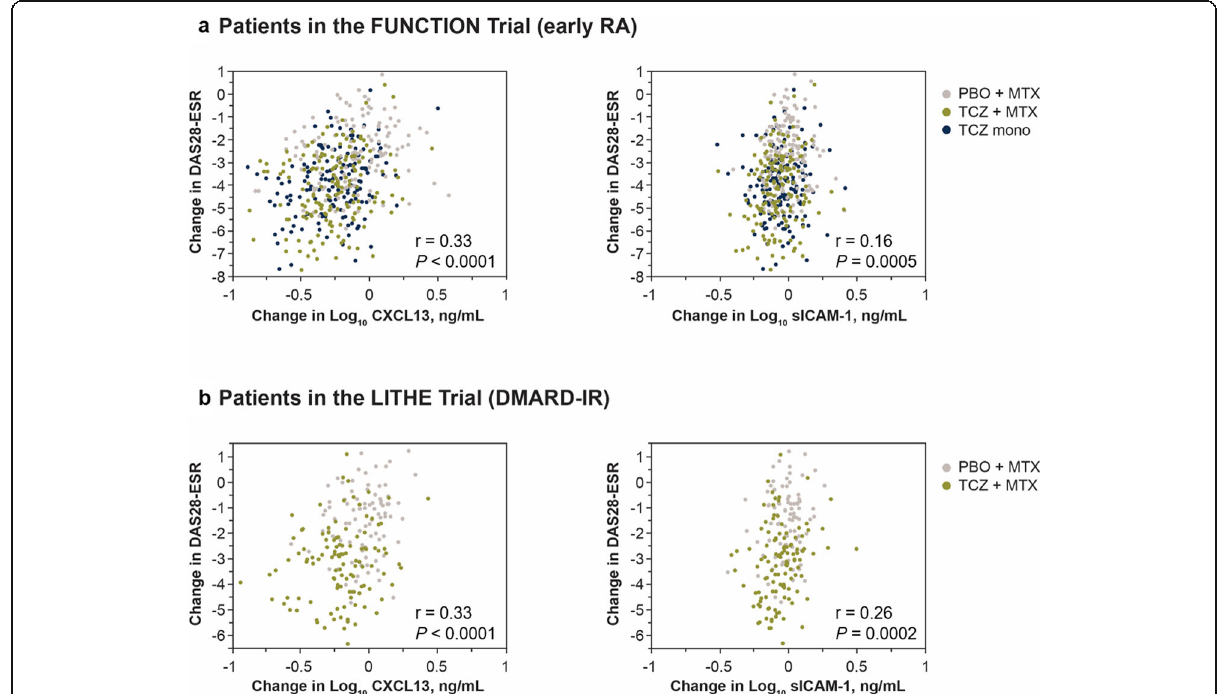
Fig. 4 Correlation Between Change in Serum Levels of CXCL13 and sICAM-1 and Change in DAS28-ESR at Week 24. CXCL13, C-X-C motif chemokine ligand 13; DAS28-ESR, Disease Activity Score in 28 joints calculated with erythrocyte sedimentation rate; DMARD-IR, inadequate response to disease-modifying antirheumatic drugs; MTX, methotrexate; PBO, placebo; RA, rheumatoid arthritis; sICAM-1, soluble intercellular adhesion molecule-1; TCZ,